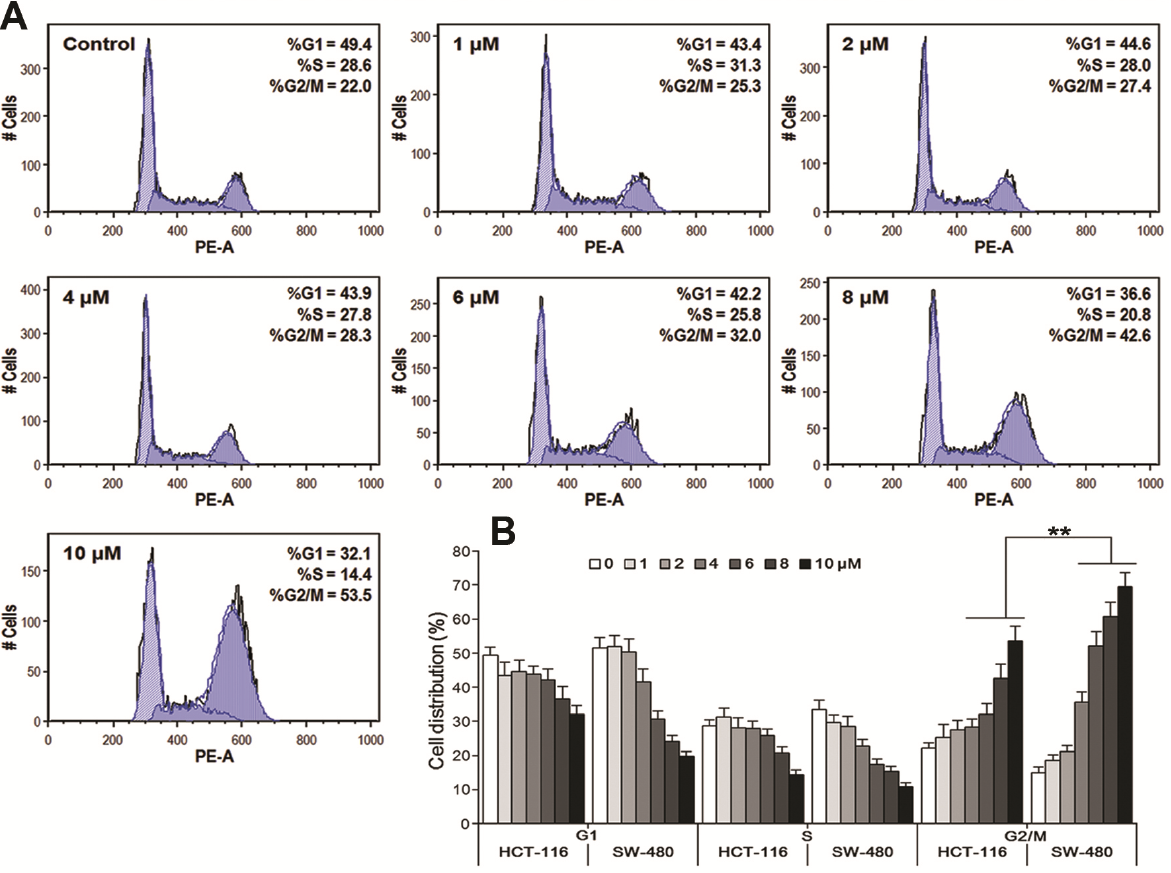
Figure 5. Oplopantriol A (OPT A) induces G2 cell cycle arrest in HCT-116 and